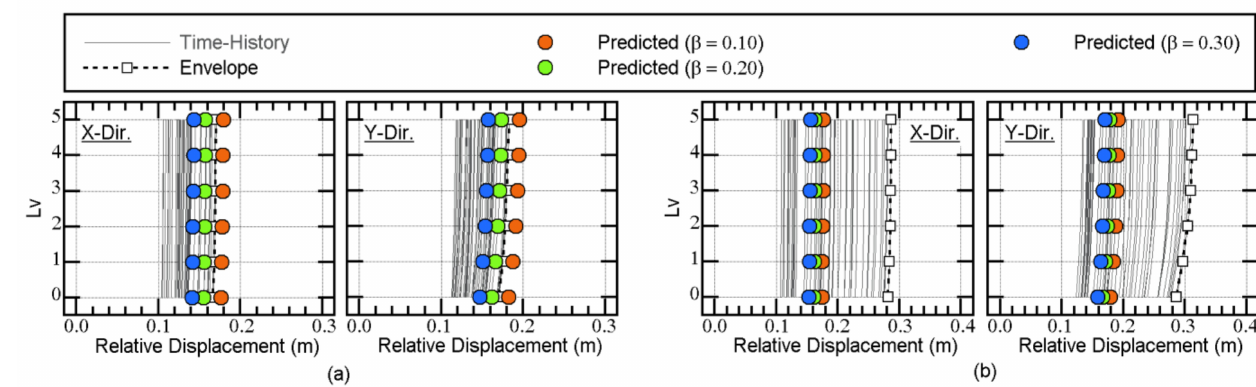
Figure 20. Comparison of the peak relative displacements at X 3A Y 3 (Model-Tf34) for the ( a ) Art-1 and ( b ) Art-2 series.